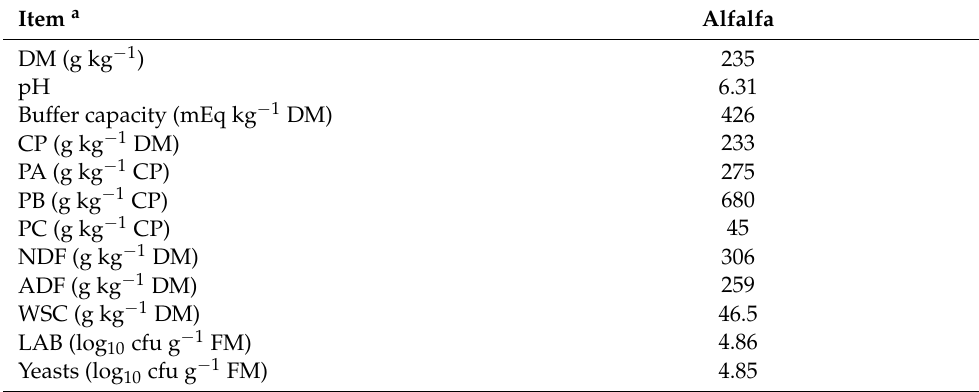
Table 1. Chemical composition and microbial counts of fresh